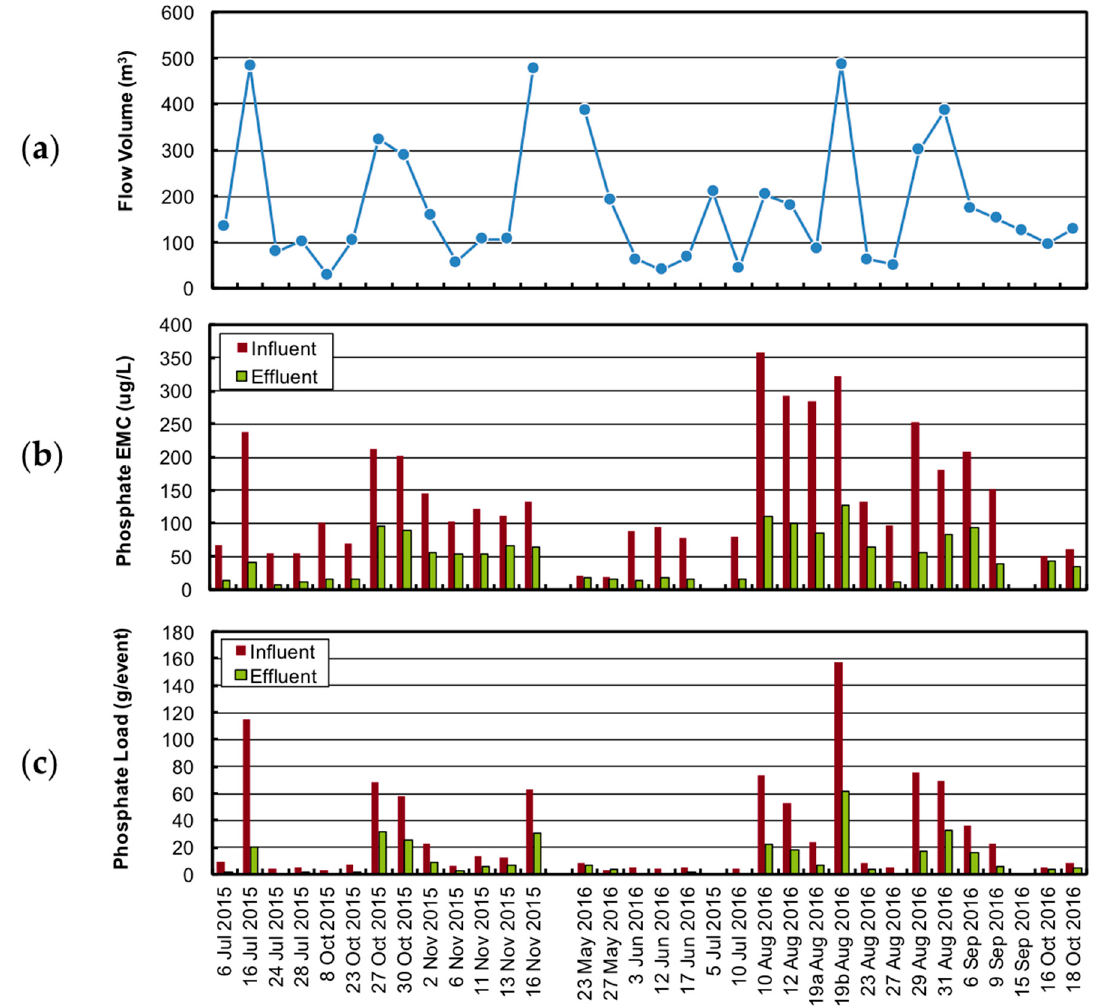
Figure 6. ( a ) Rainfall-induced tile drainage, phosphate influent and effluent ( b ) EMC and ( c ) load for 2015 and 2016.